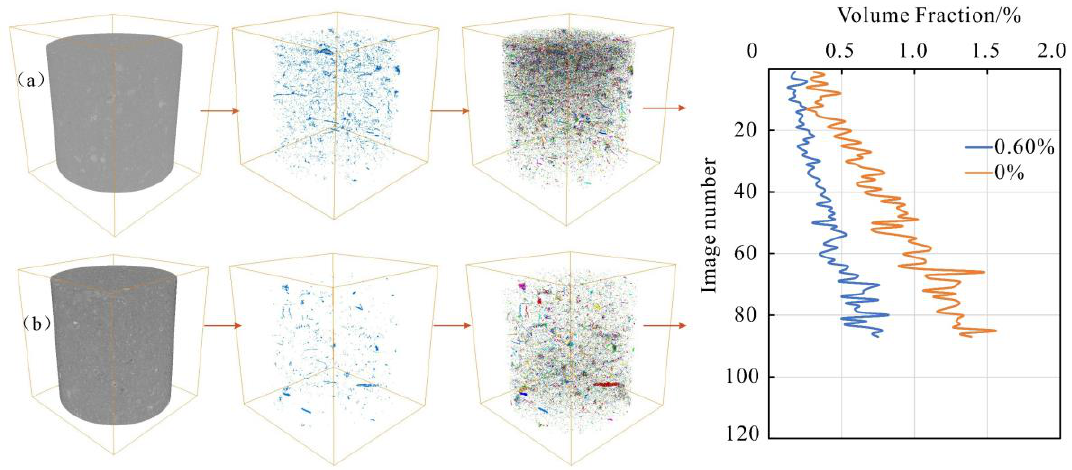
Figure 18. 3D pore structure of loess before and after reinforcement: ( a ) 0%; ( b ) 0.6%.